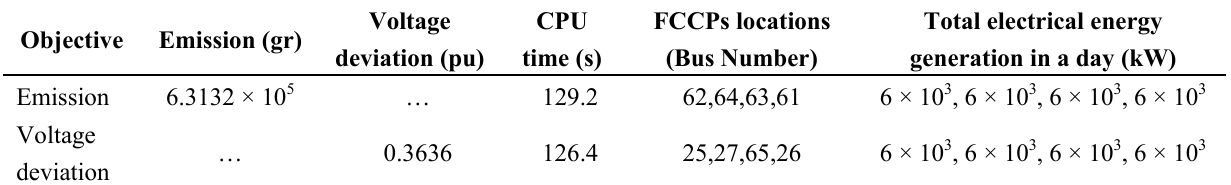
Table 6. Results obtained by optimizing the emission and voltage deviation.